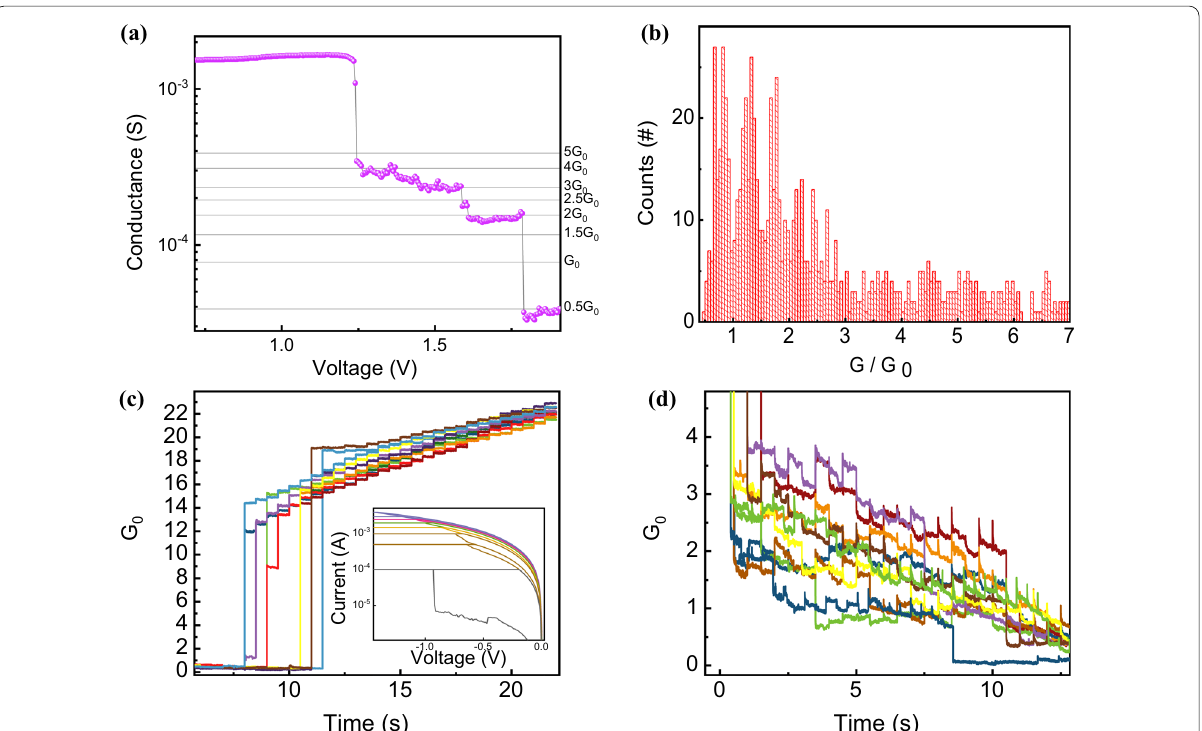
Fig. 5 a Quantized conductance characteristic using DC measurement on reset part, and b histogram of quantized conductance levels. Quantized conductance characteristic using pulse measurement c in set region, d in reset region